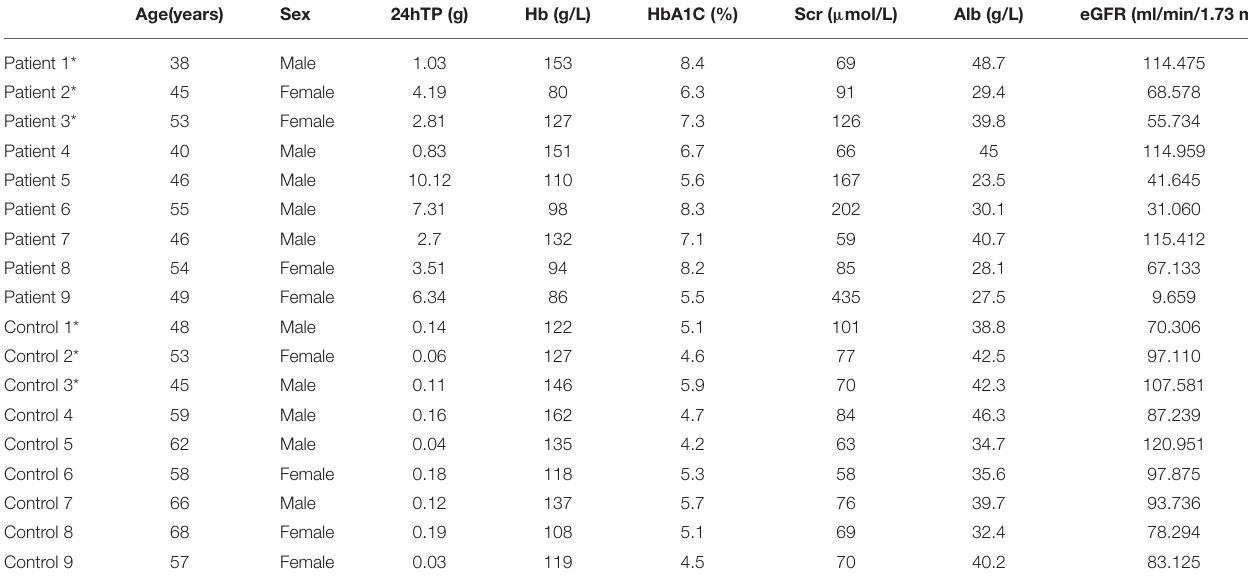
TABLE 2 | Clinical data of patients.